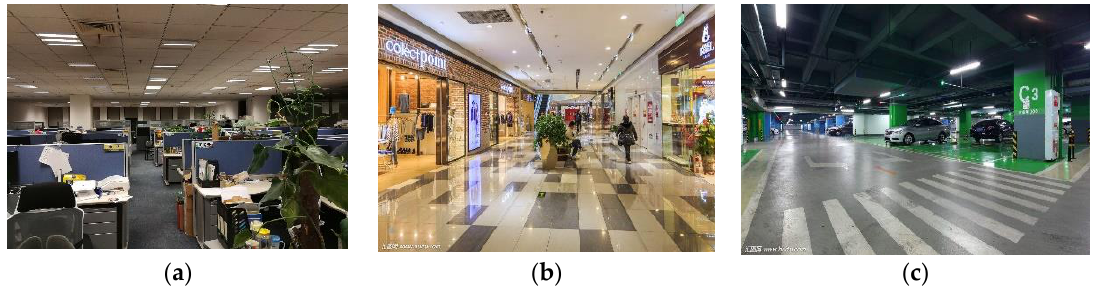
Figure 18. Typical indoor scenarios. ( a ) Office; ( b ) Shopping mall; ( c ) Parking lot.